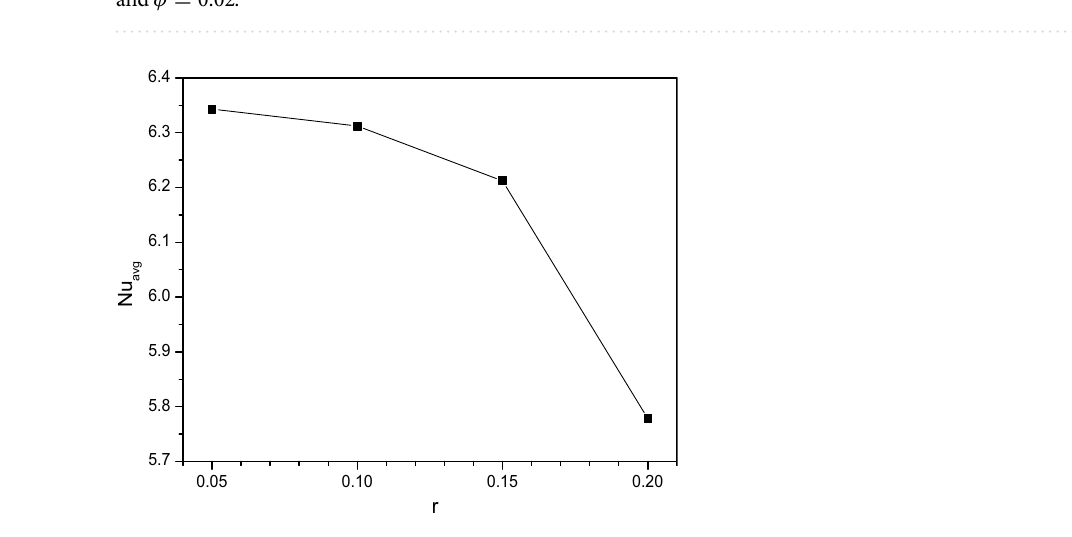
Figure 24. Variations of Nu avg with r when Ra = 10 6 , Da = 0.01 , Ha = 0 , ω = 0 , N = 4 , r = 0.1 and φ = 0.02